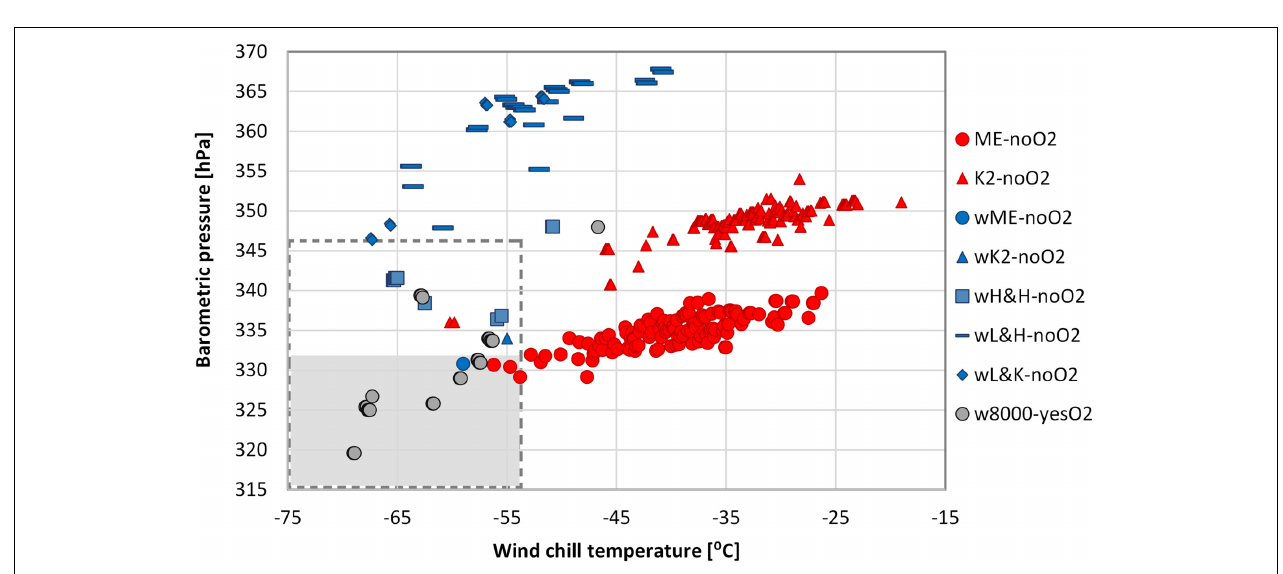
FIGURE 3 | Wind speed experienced on the summits we analyzed. Sample size – 499 ascents without supplemental oxygen and 29 with supplemental oxygen (1978–2021). Bars extend to the maximum and minimum wind speed, boxes span the 25th–75th percentiles, crosses inside the boxes mark mean values, horizontal lines inside the boxes represents median values, dots mark outliers, dotted line represents 90th percentile value of 25 m · s − 1 for all 499 ascents without supplemental oxygen.